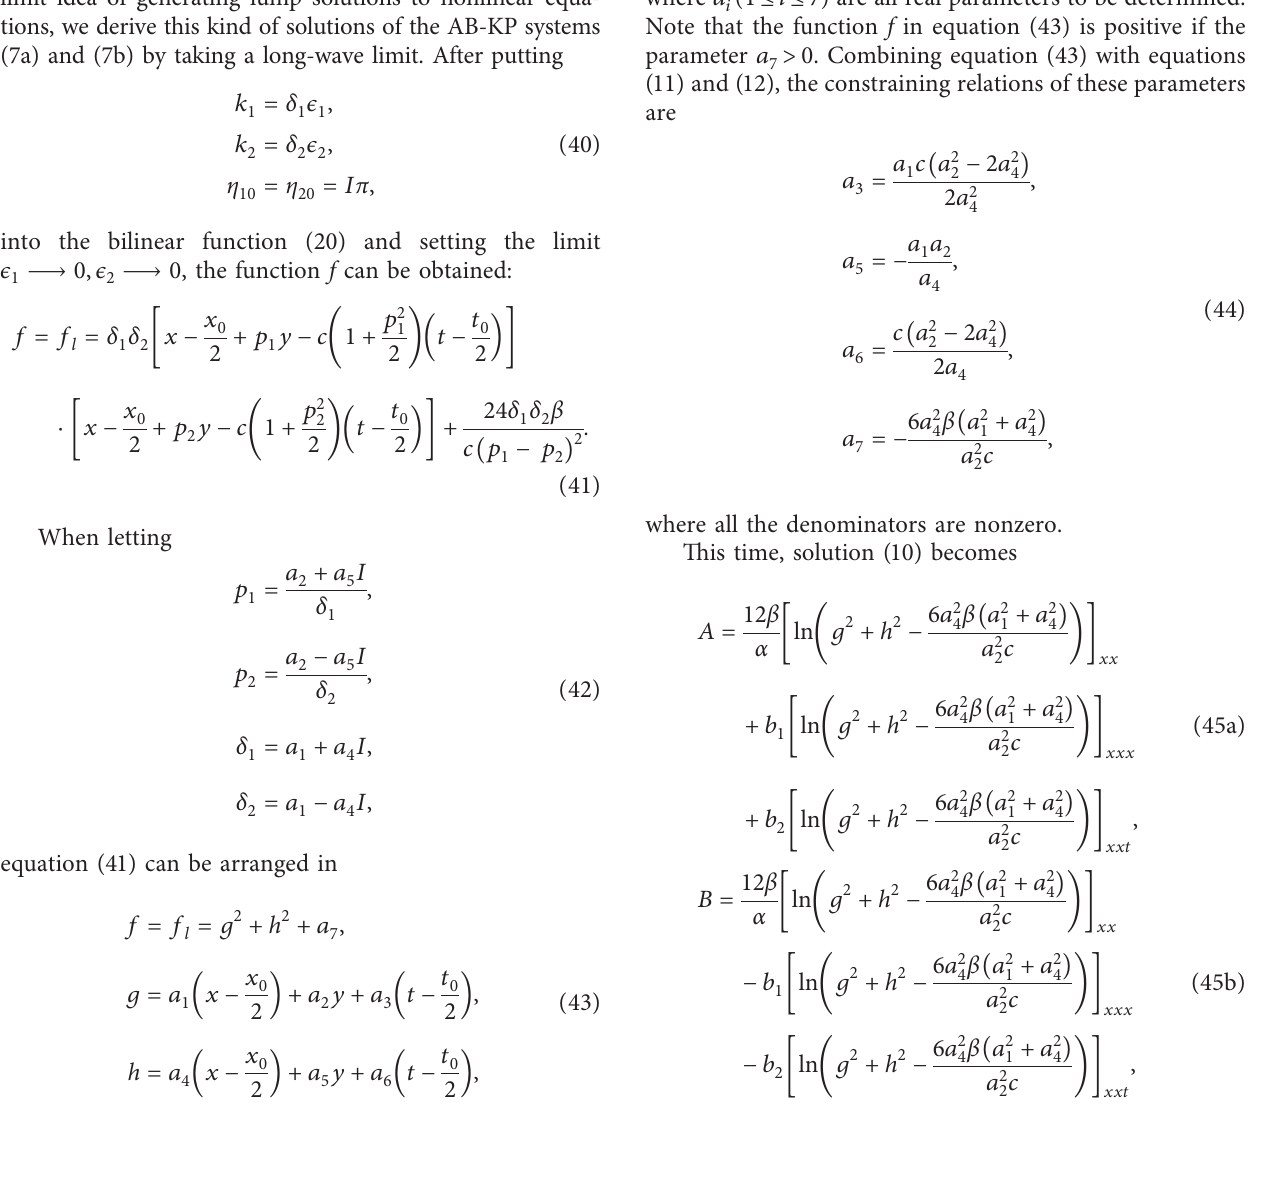
� b � 10, at time t � 1 2